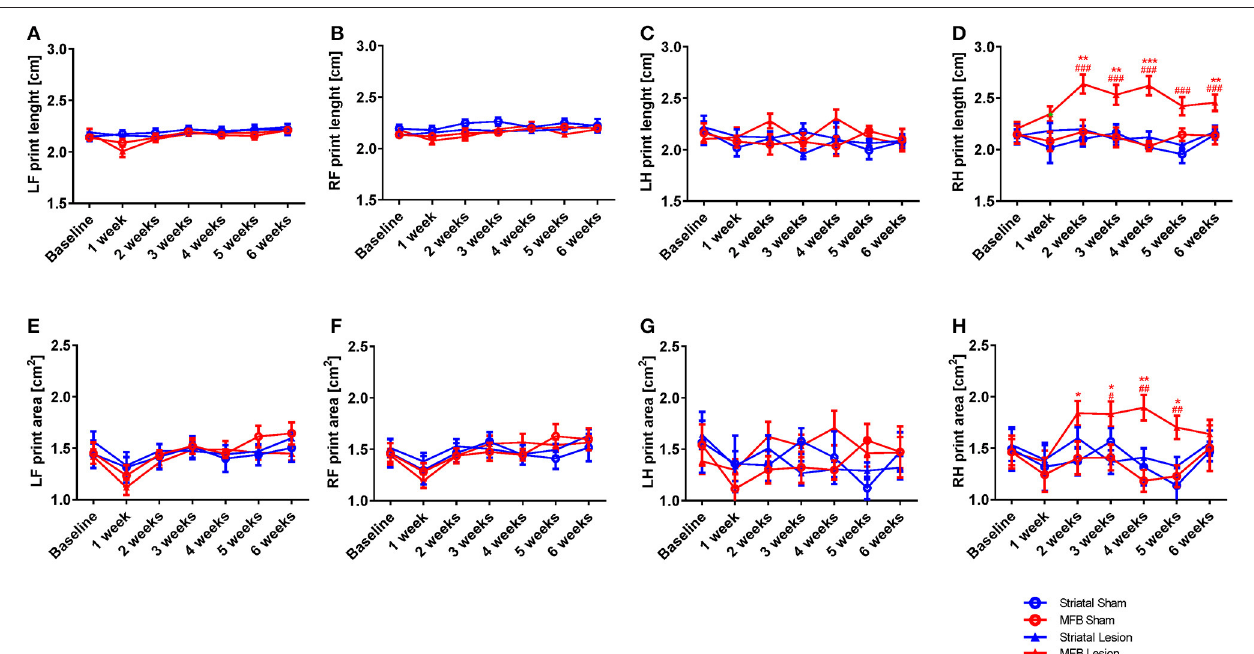
FIGURE 7 | Print length and print area following MFB and striatal 6-OHDA lesioning. Graph demonstrate (A–D) the length of the complete prints and (E–H) the print area. Data shown as mean ± s.e.m. *Indicates a significant difference on the lesion group when compared to its control (blue for striatal cohort and red for MBF cohort) and # indicates differences of MFB lesion vs. striatal lesion animals. * P ≤ 0.05; ** P < 0.01; *** P < 0.001 (Two-way repeated measures ANOVA with Tukey’s or Dunnett’s post-hoc multiple